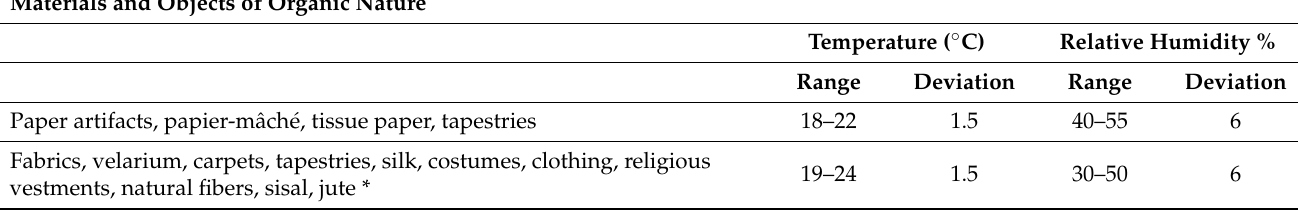
Table 1. Temperature and relative humidity reference and deviation values for different categories of artifacts (from